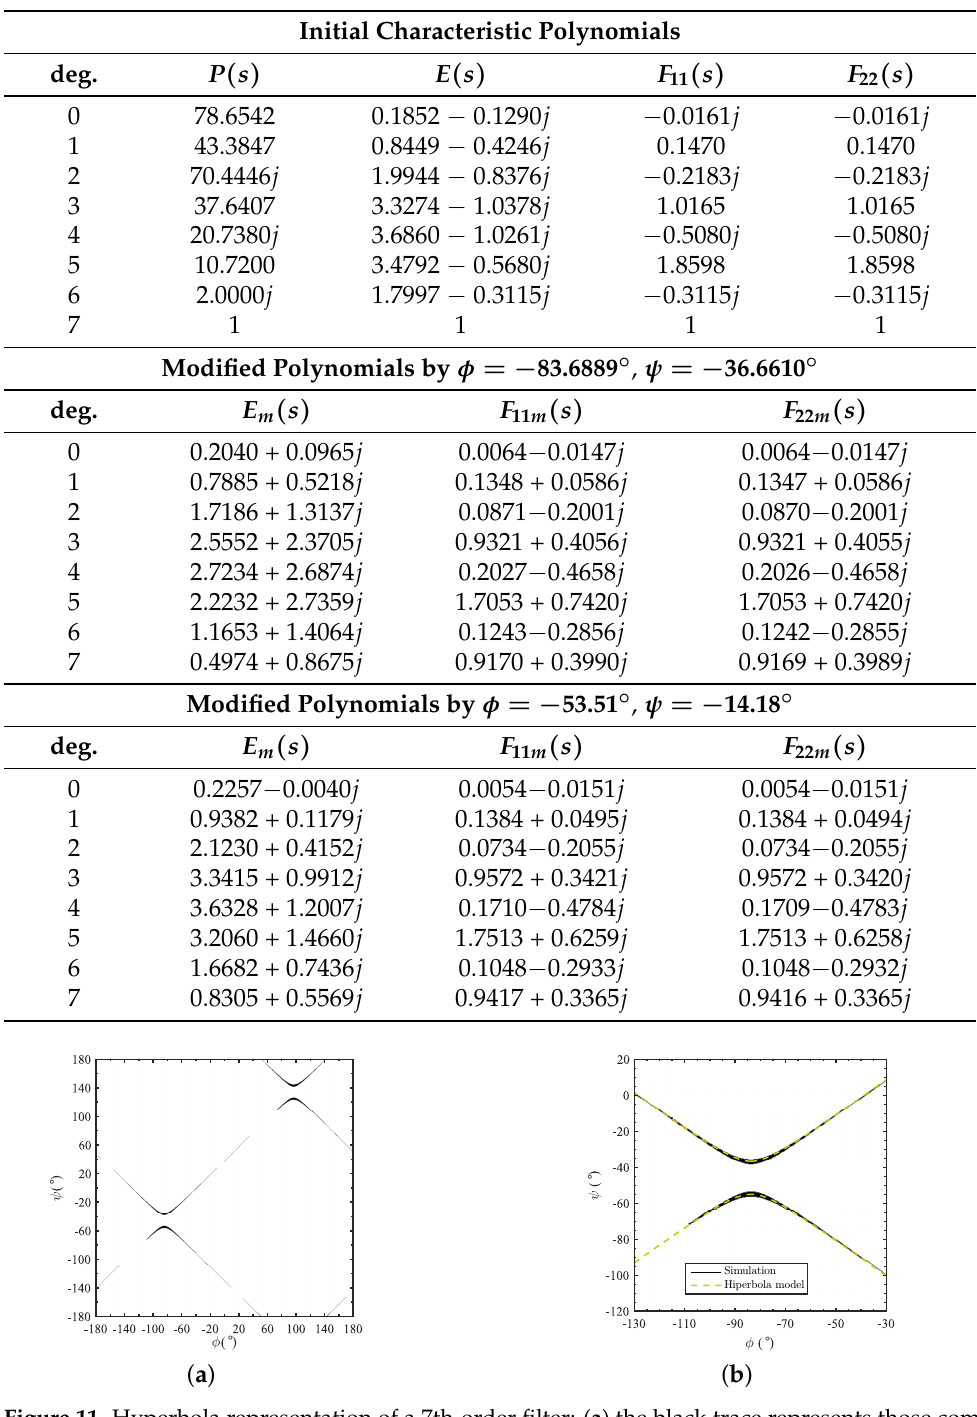
Table 5. Characteristic polynomial coefficients for the filter with Ω tz TZs distribution and RL = 18 dB for different additional phase terms.